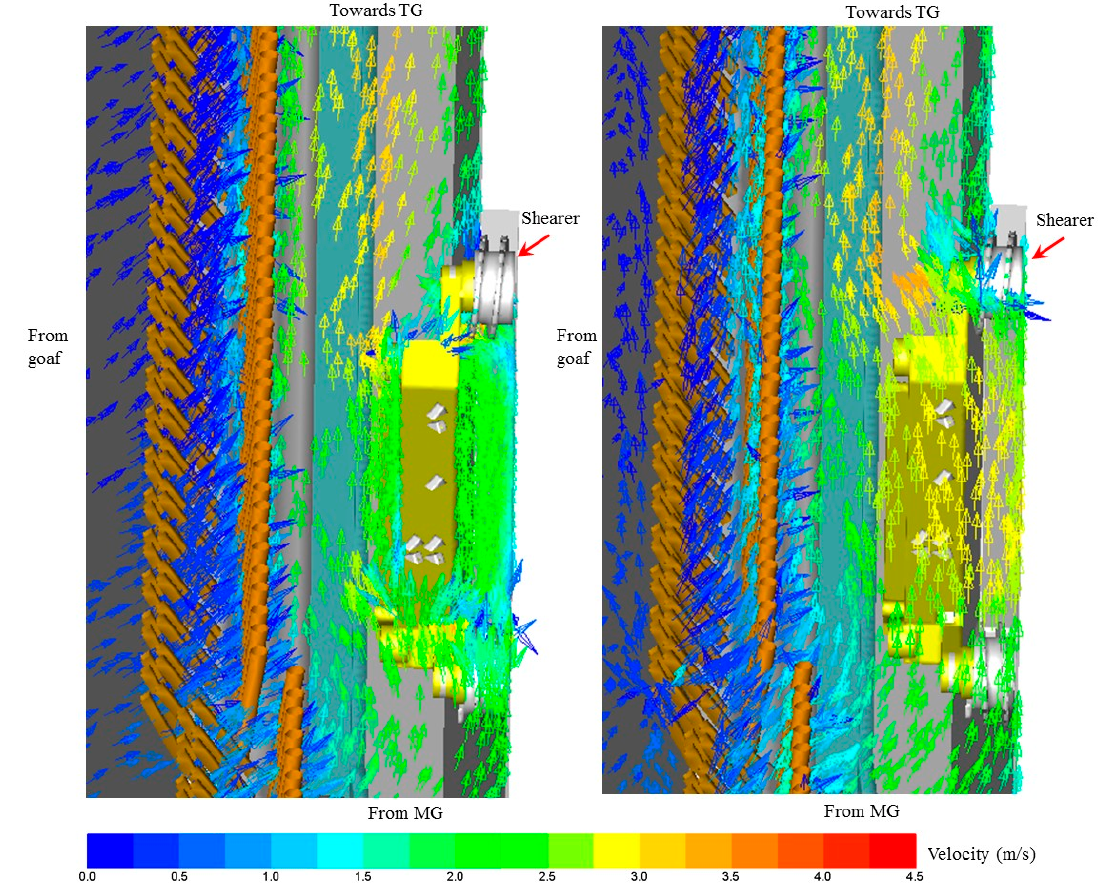
Figure 7. 3D view of airflow velocity vectors around the shearer for base model ( Left : Near the top of the shearer; Right : 1 m above the shearer).